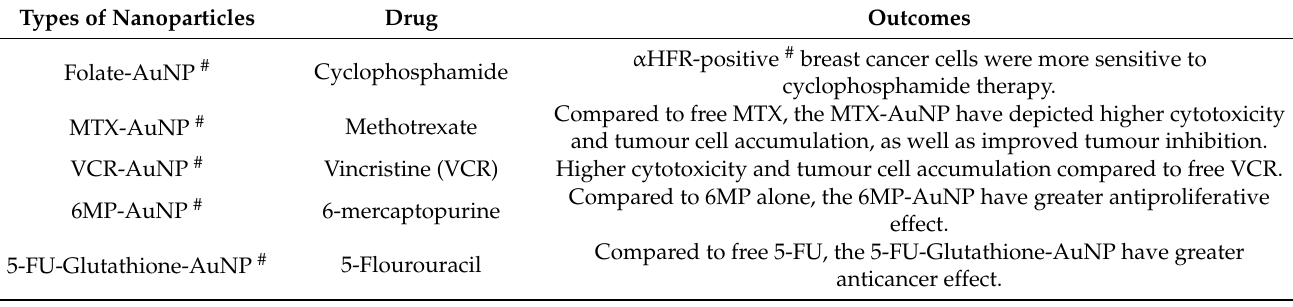
Table 6. Applications of MSNs using cancer models for improved cancer therapy. Reproduced with permission from reference [106].